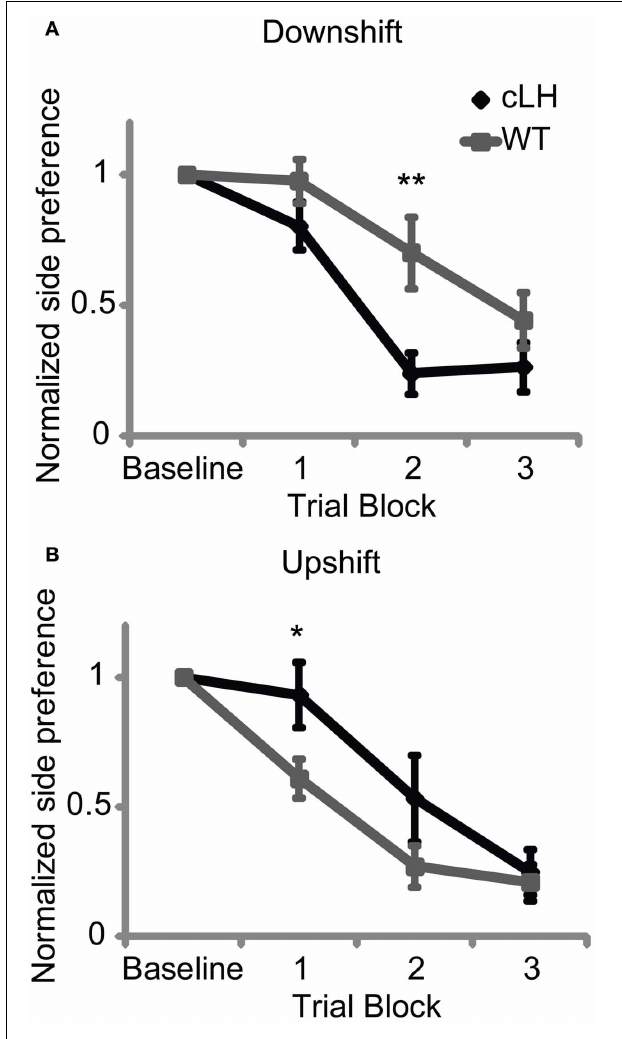
FIGURE 1 | Negative learning bias in cLH rats. (A) cLH rats switched their preference away from the downshifted side more quickly than WT rats. (B) cLH rats switched their preference toward the upshifted side more slowly than WT rats. ∗∗ P < 0 . 01; ∗ P < 0 . 05. Student’s t -tests on individual trial blocks. Error bars indicate s.e.m.